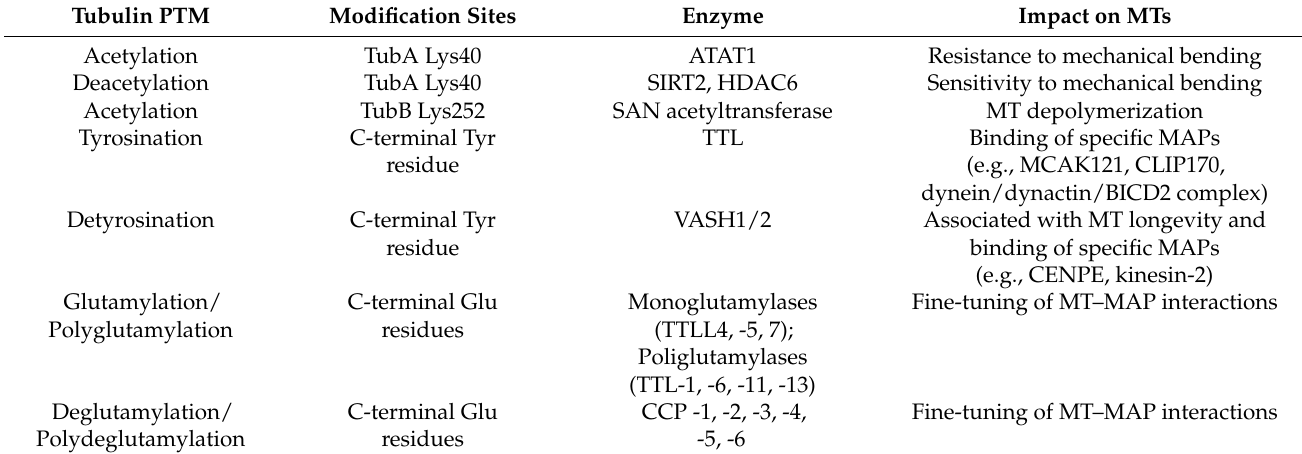
Table 1. Tubulin post-translational modifications (PTMs) and MT dynamics and